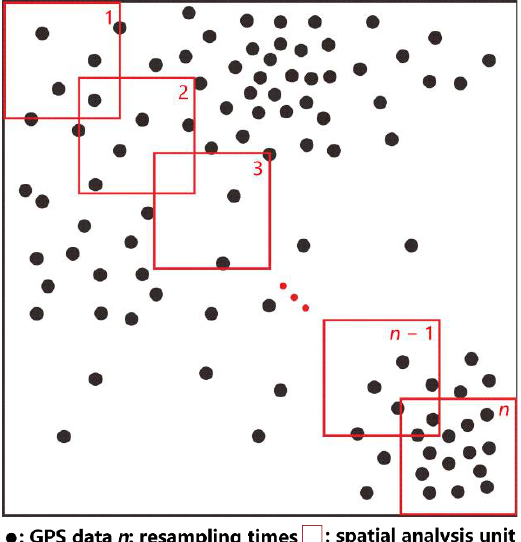
Figure 3. Resampling method based on spatial location (1, 2, ... n represent the sampling times).